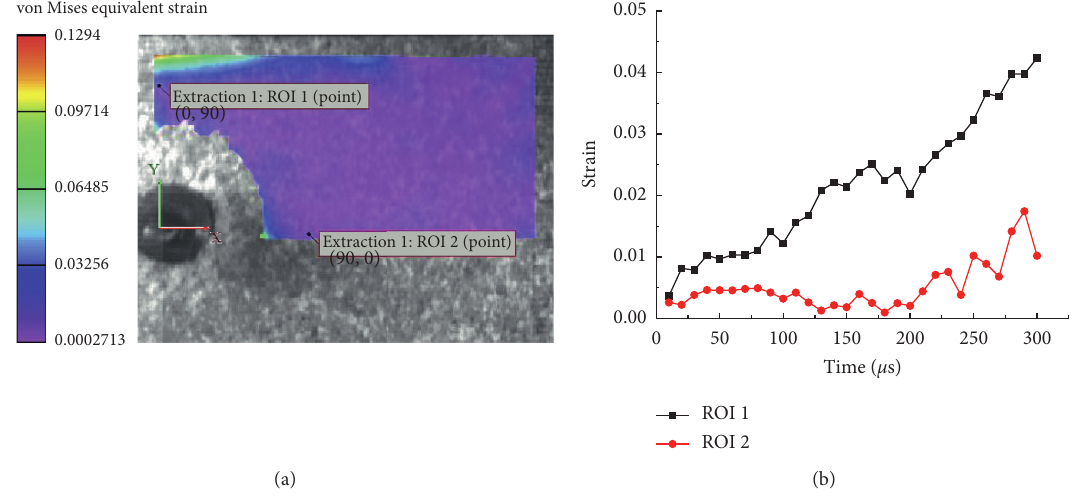
Figure 4: Von Mises strain for test 2. (a) von Mises strain field at 90 μ s and (b) curves of von Mises